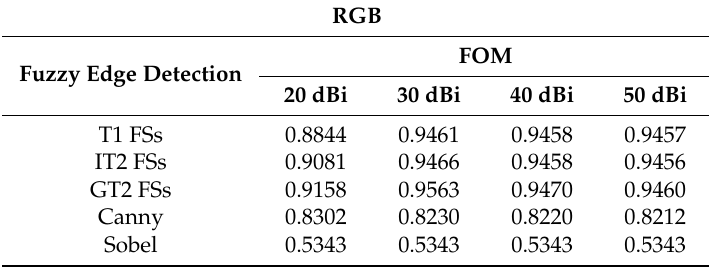
Table 12. T1, IT2, and GT2 FS edge detection applied on RGB color format images with Gaussian noise. Table 11. T1, IT2, and GT2 FS edge detection applied on HSV color format images with Gaussian noise.